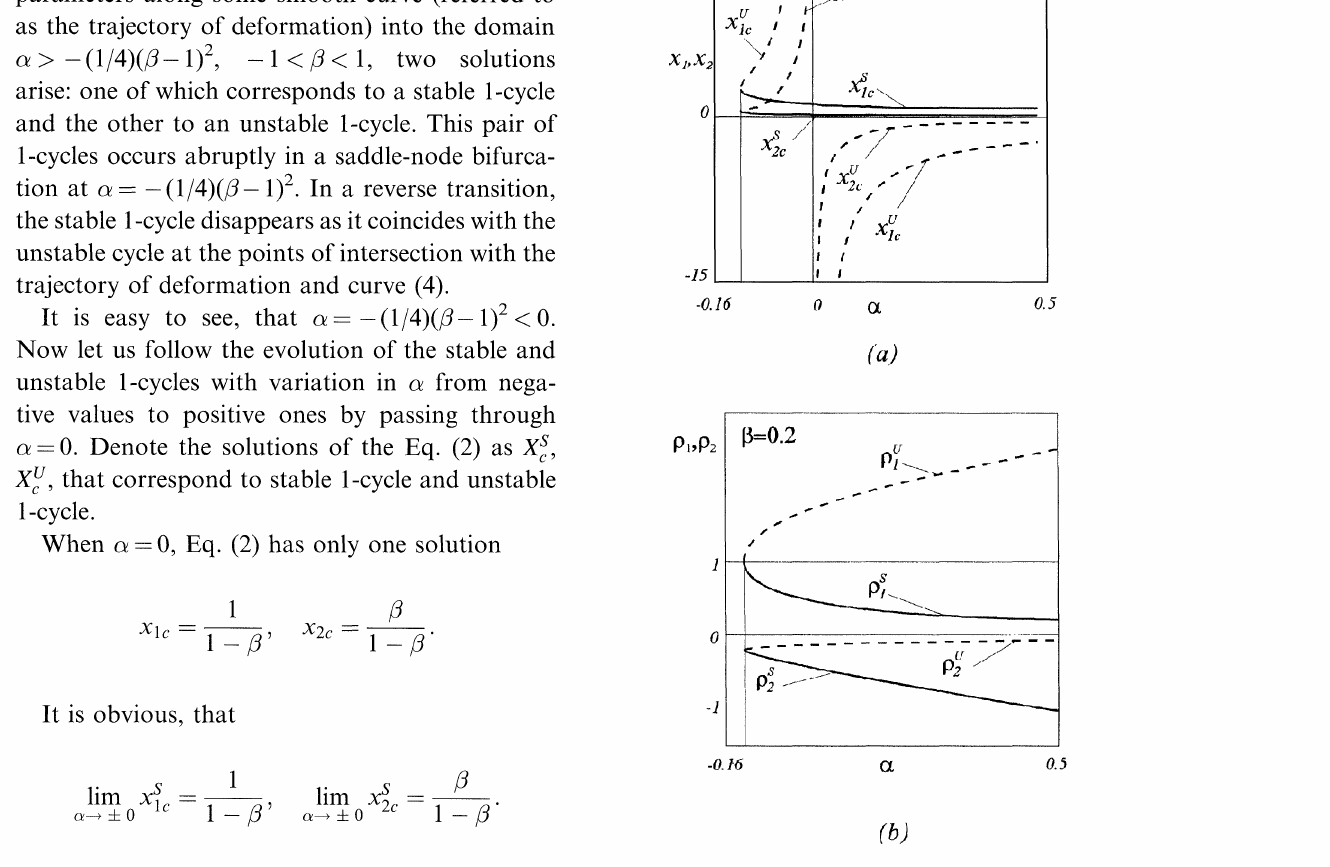
(a) Variation of the stable and unstable period-1 cycles with the nonlinearity parameter c. Note the different nature of these dependences. (b) Corresponding variation ofthe multiplicators Pl and/)2. Equation (2) when m- 2 takes the form oz3X41c 1- This equation has four real roots in the domain a > (3/4)(/3- 1) 2. Two of the roots correspond to two unstable 1-cycles. It is not difficult to show, that a stable 2-cycle satisfies the